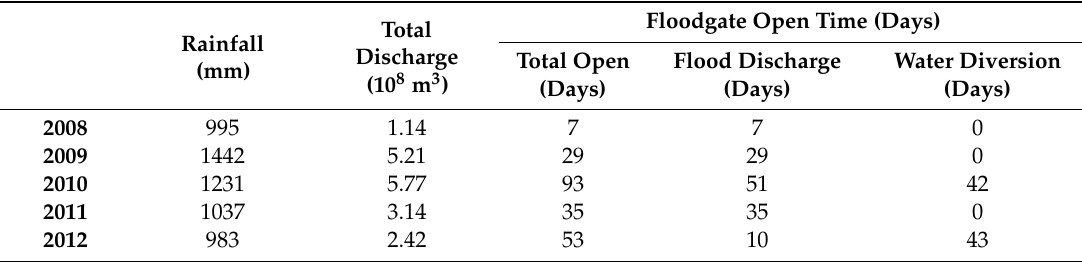
Table 5. Possible factors influencing water quality in the Qinhuai